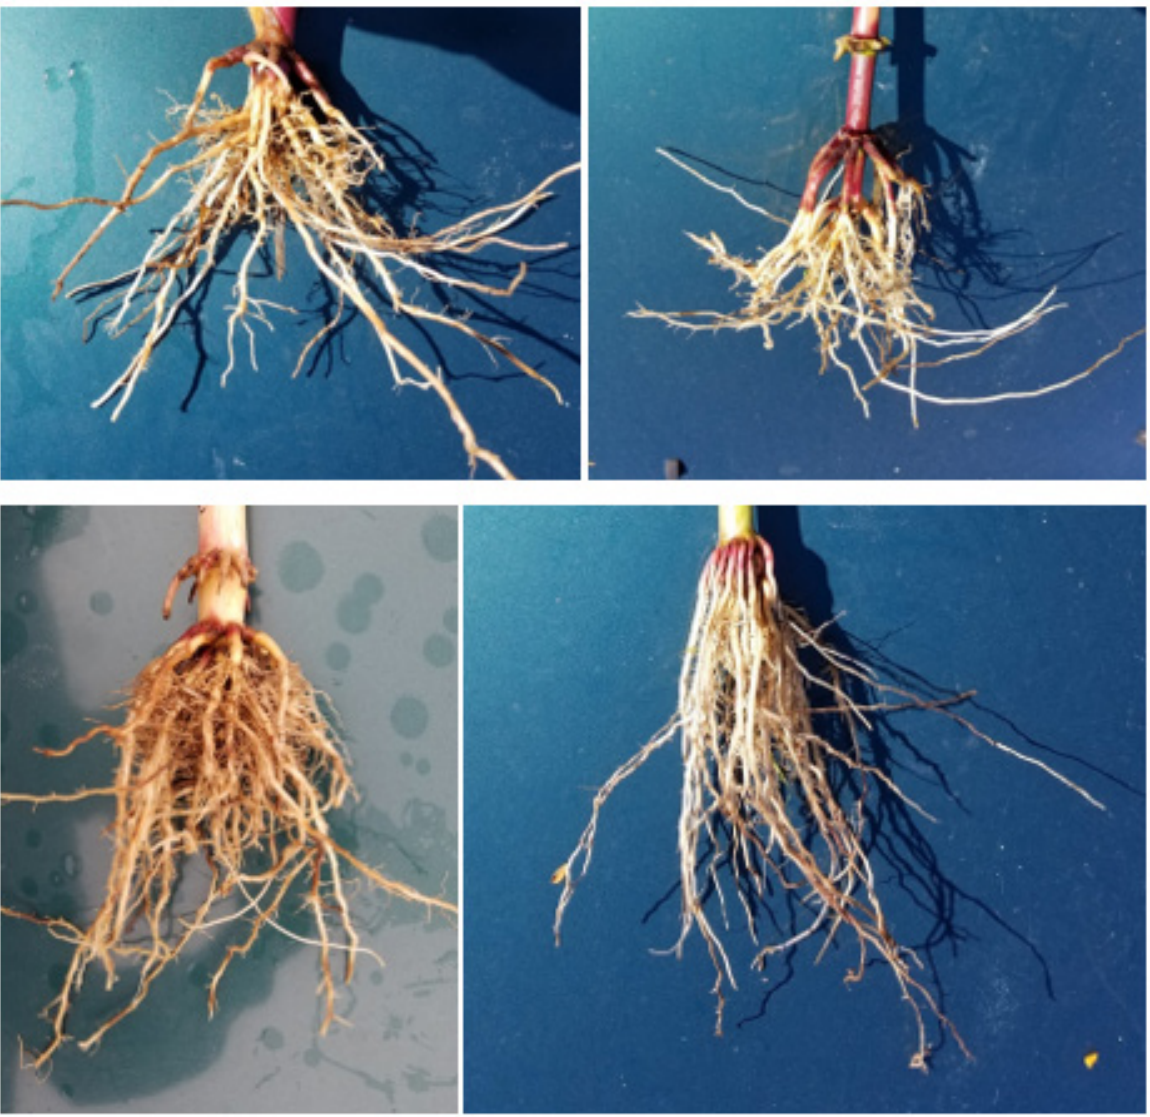
Figure 12: Root systems for conventionally bred cultivars grown on N limited sites in 2017 on the JR field (pictures at top and bottom left) and from the Creek Field (bottom right) Picture in top left) is LH206; picture in top right is LH123Ht; picture in bottom left is S7; picture in bottom right is S5. LH206 and LH123Ht were bred by the Holdens Seed Company (now owned by Bayer). S7 and S5 are commercial inbreds from